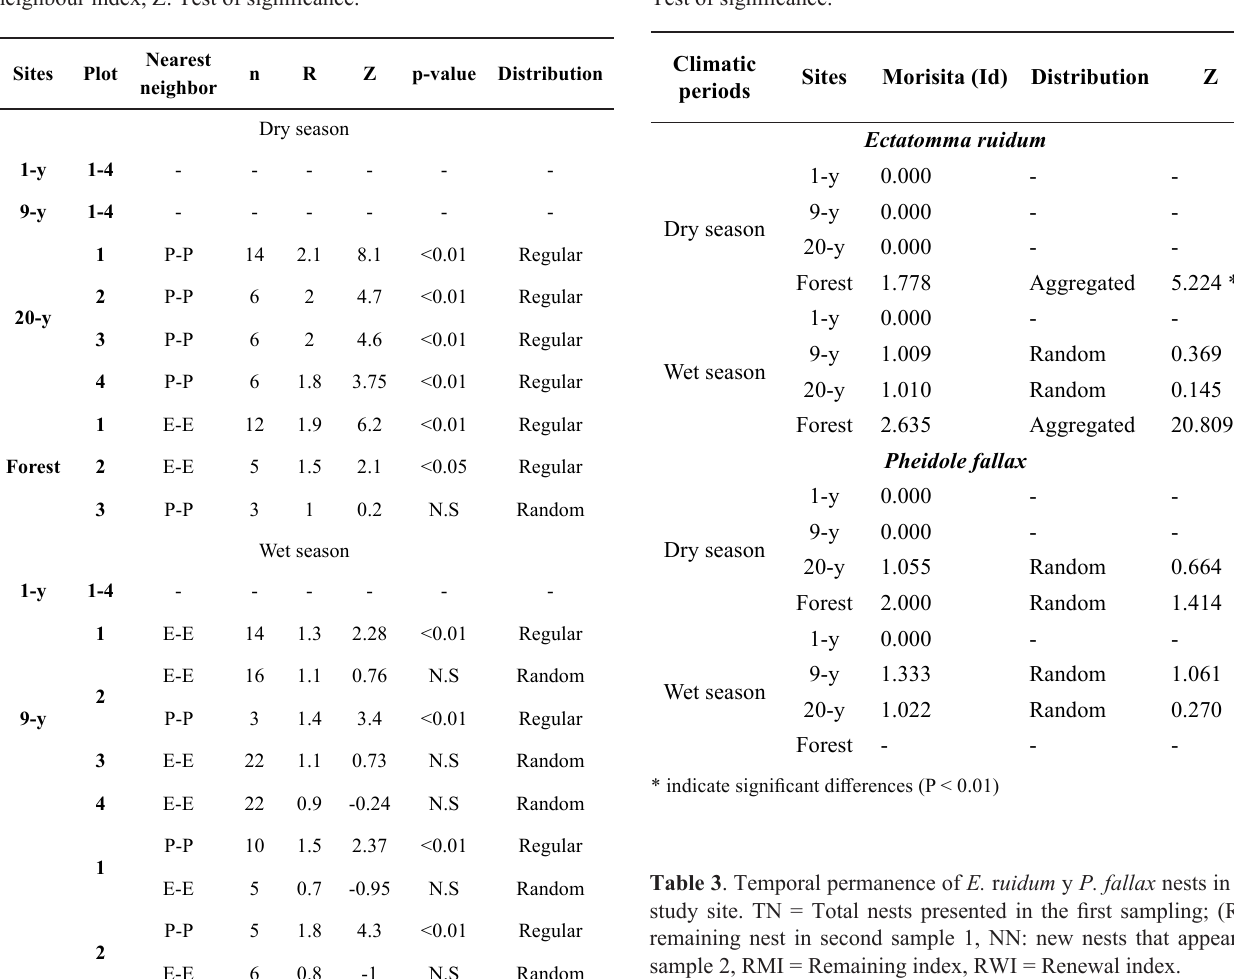
Table 2. Spatial distribution of nests belonging to E. ruidum (E) and P. fallax, (P) at site scale, according to , Morisita’s index ( Id ). (Z): Test of significance.